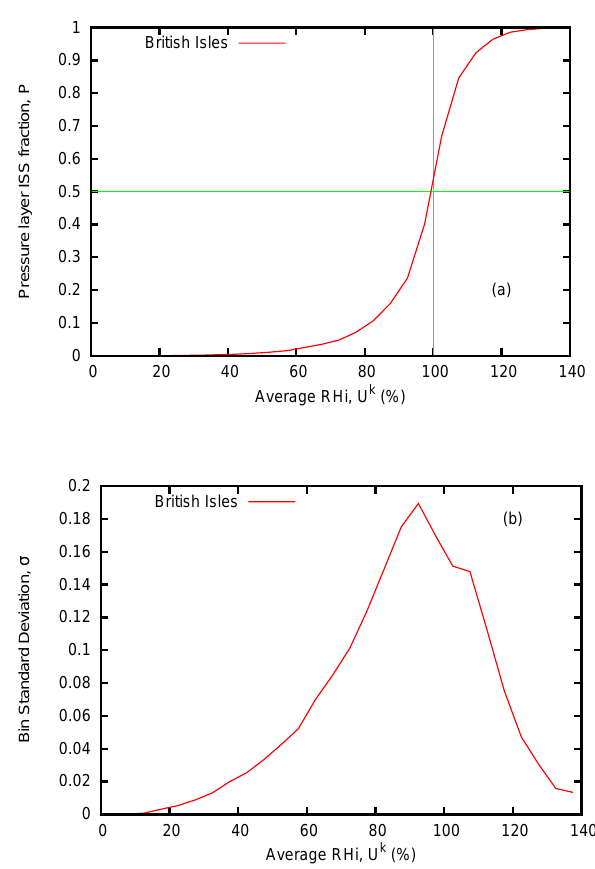
Fig. 5. Panel (a) shows the probability relationship between Fig. 5. (a) Probability relationship between the average RHi and the the average RHi and the ISS fraction, P(u ± 1u/ 2 ) , for 50-hPa ISS fraction, P ( u ± ∆ u/ 2) , for 50-hPa layers (400–150hPa). (b) layers (400–150hPa). Panel (b) shows the standard deviation Standard deviation for the British Isles dataset from the s-shaped for the British Isles dataset from the s-shaped mean (in each mean (in each relative humidity bin). The analysis was performed relative humidity bin). The analysis was performed from five from five years of high resolution radiosonde launches from Cam- borne, Castor Bay, Herstmonceux, Albemarle, Lerwick and Watnall years of high resolution radiosonde launches from Camborne, (January 2002–December 2006). Castor Bay, Herstmonceux, Albemarle, Lerwick and Watnall (January 2002–December 2006).